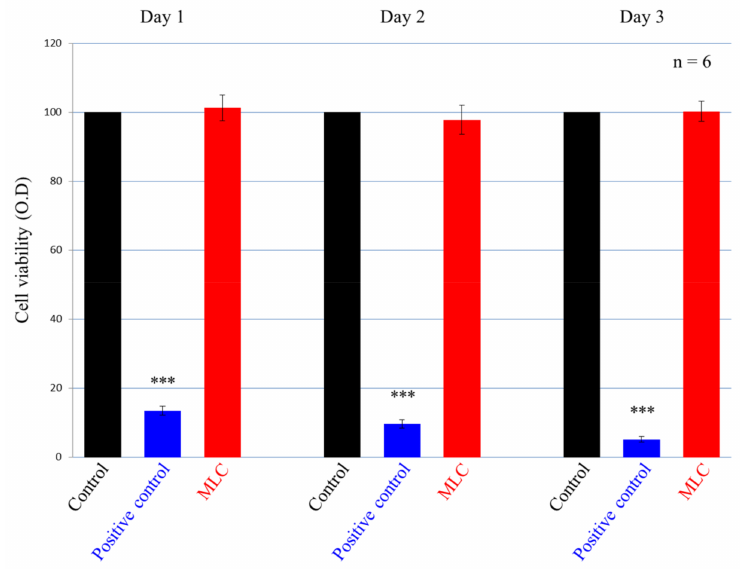
Figure 8. WST-1 assay of the control group, positive control group, and MLC extraction treated 3T3 cells at 24, 48, and 72 h. Only the positive control group was statistically significantly di ff erent from the other two groups (*** represents p < 0.001); the MLC was not significantly di ff erent from the control